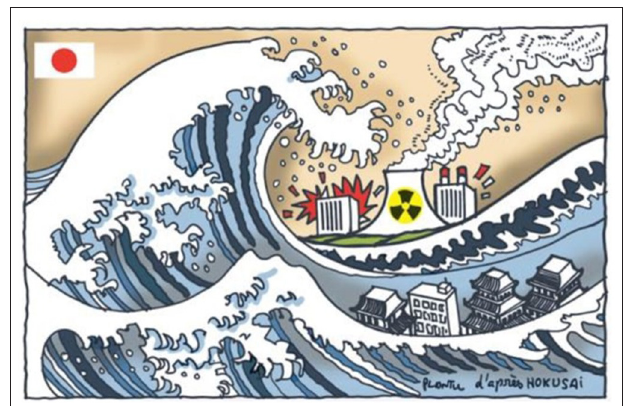
FIGURE 8 | Jean “Plantu” Plantureaux’s remix of Great Wave in the wake of the Fukushima Daiichi nuclear disaster. © Plantu, dessin paru dans Le Monde du 15 mars 2011 Autorisation à titre gracieux. Reproduced from Helmreich (2015)